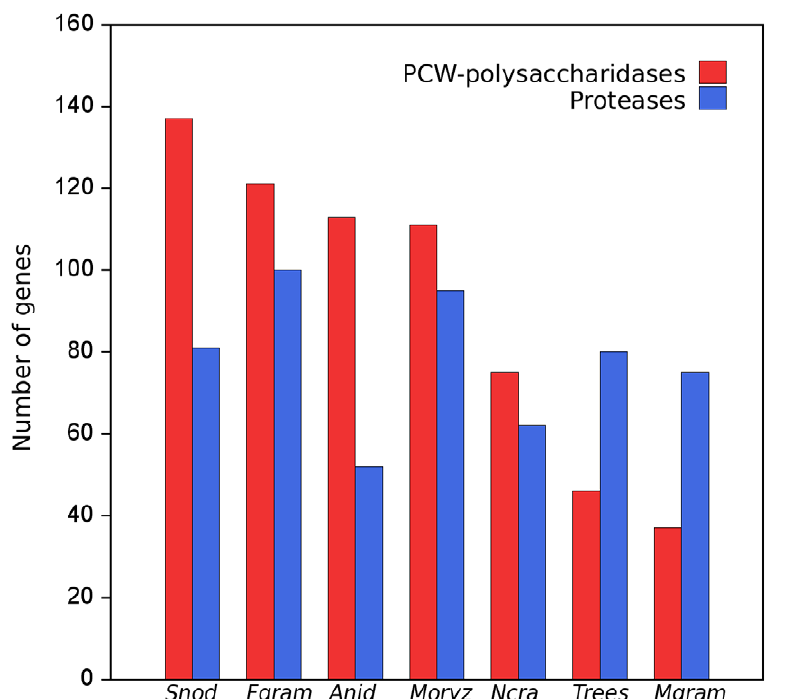
Figure 6. Numbers of genes for proteases and plant cell wall (PCW) degrading polysaccharidases in the genomes of seven fungi with sequenced genomes. Genes for PCW-polysaccharidases were severely reduced in the genome of Mycosphaerella graminicola but proteases were about the same. The overall profile of the enzymes in M. graminicola was most similar to that of T. reesei than to any of the other plant pathogens. Species analyzed included the saprophytes Aspergillus nidulans (Anid), Neurospora crassa (Ncra), and Trichoderma reesei (Trees), and the plant pathogens